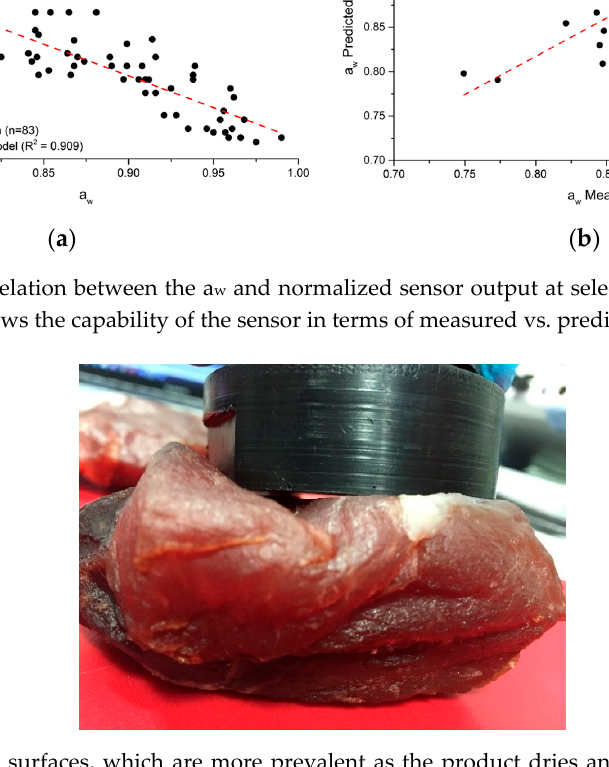
Figure 3. Uneven surfaces, which are more prevalent as the product dries and hardens, introduce gaps between the sensitive surface of the microwave probe and the